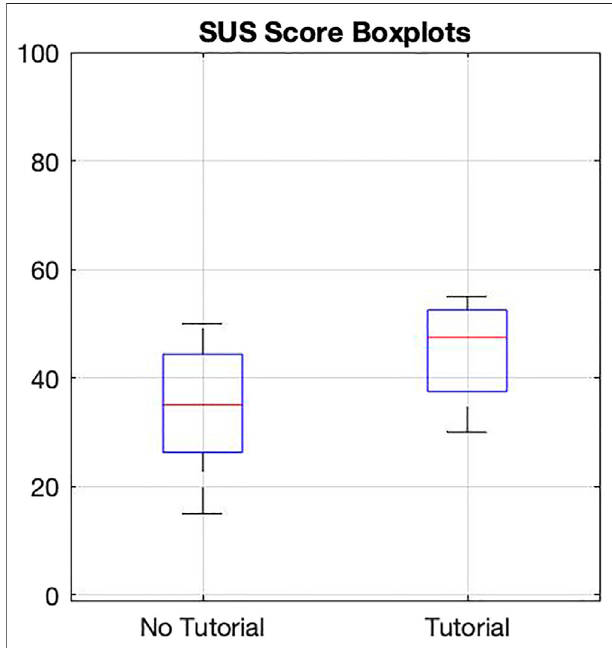
FIGURE 2 | SUS scores of users receiving tutorial and those who did